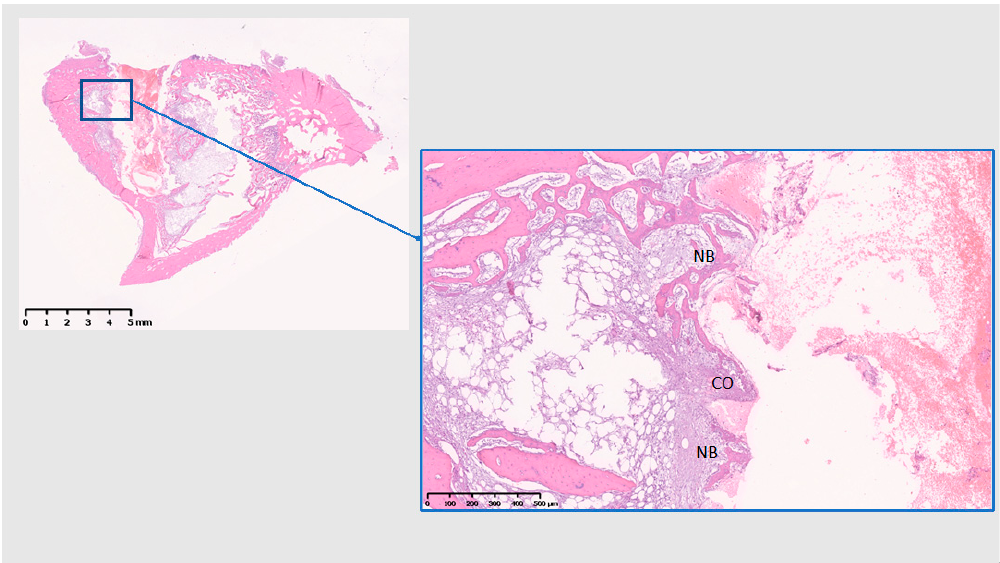
Figure 8. Histological analysis of Ti (10 days). NB : New bone; CO : Contact osteogenesis. Collagen proliferation and some initial calcification to form new bone in the threads. Scale bars : 5 mm and 500 µm.